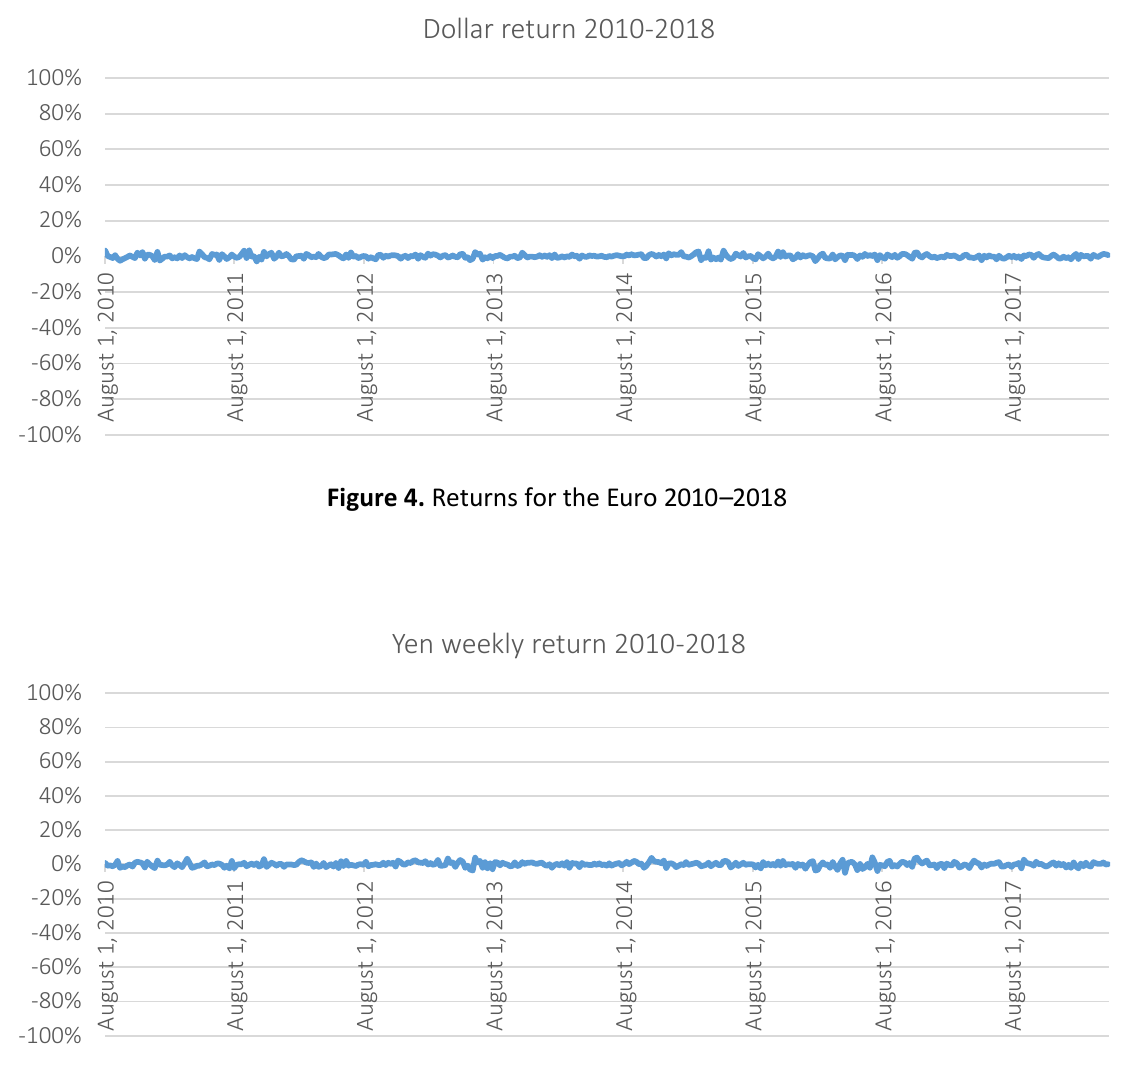
Figure 5. Returns for the Yen